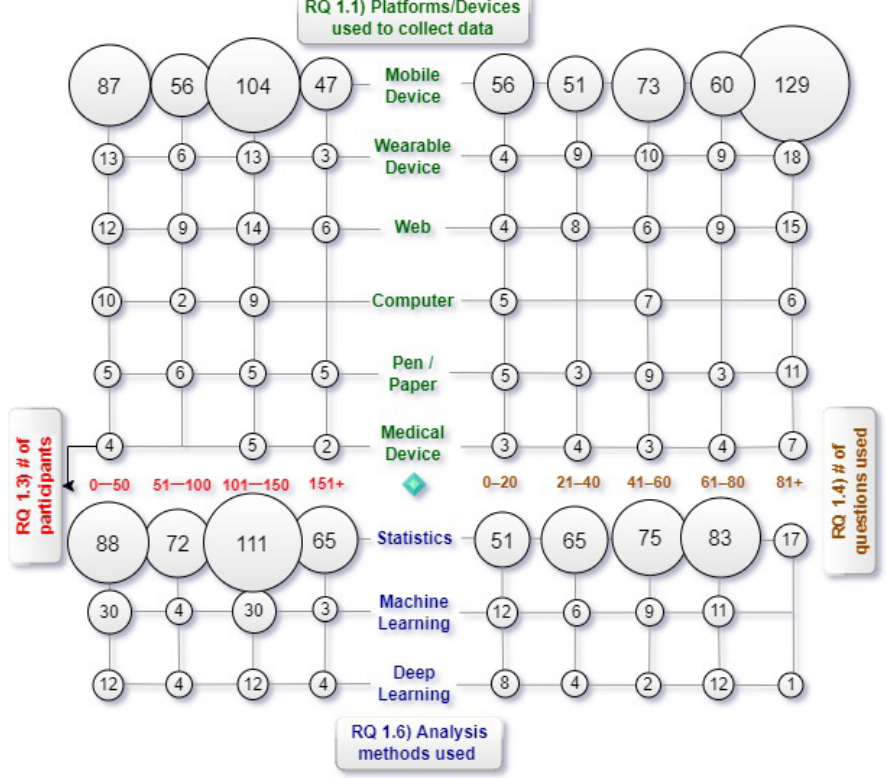
Figure 13. Mapping results obtained from the combination of Q1, Q3, Q4, and Q6. (Note that some studies may serve on multiple perspectives, e.g., studies with multiple platforms occupied S054, S062, and S084, and multiple analysis methods used S162 and